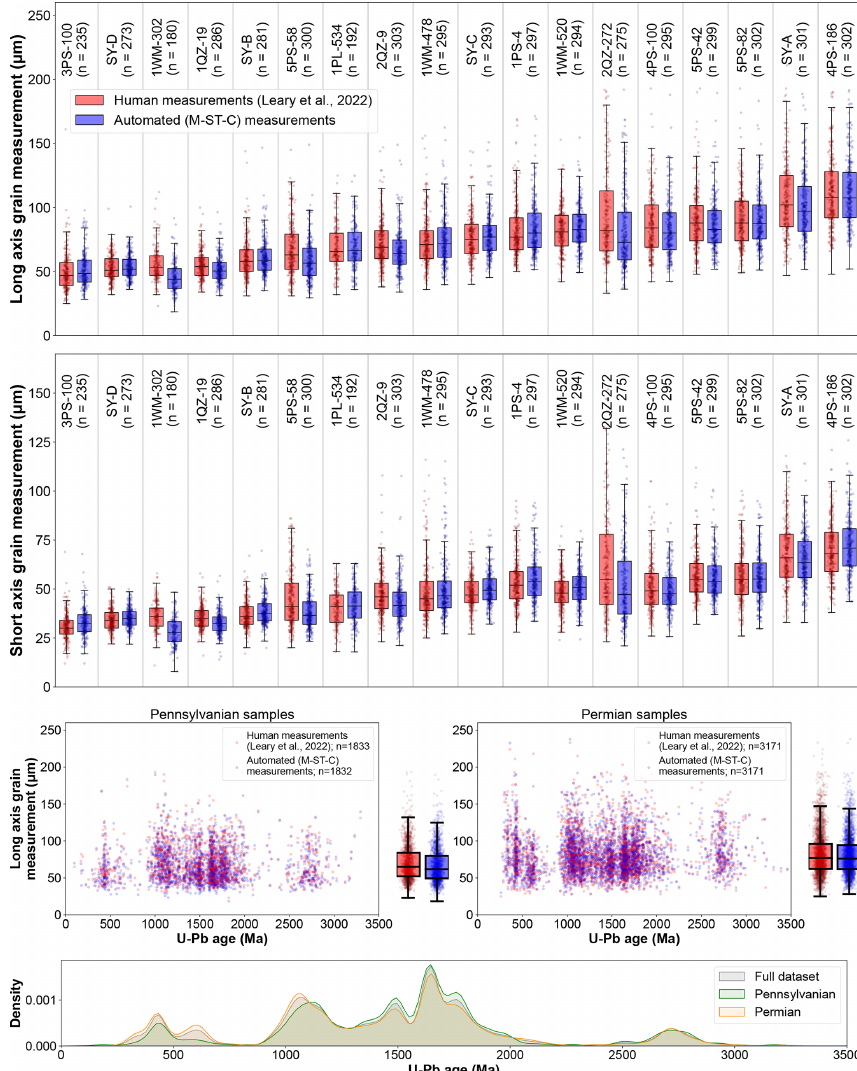
Figure 5. The top row shows a sample-by-sample boxplot comparison of human (Leary et al., 2022) and automated (M-ST-C) measurements along long and short grain axes. The middle two rows show additional scatter and bar–whisker plots showing relationships between human and automated grain long-axis length measurements and U–Pb age, with samples binned by depositional period. The bottom row shows a KDE plot of detrital zircon U–Pb ages in the Leary et al. (2022) dataset. Boxplot boxes extend from Q 1 to Q 3 , and whiskers extend